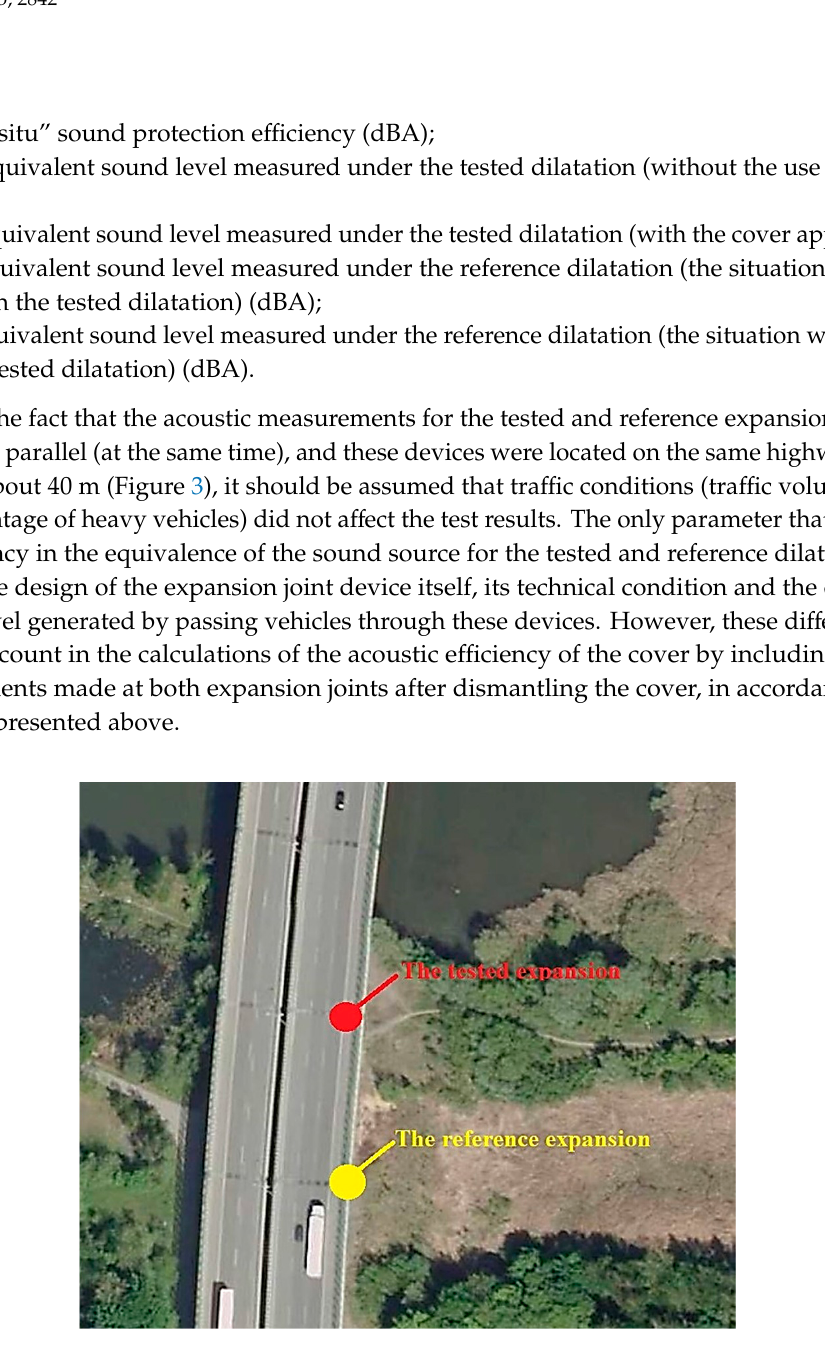
Figure 3. Location of the tested and reference expansion joint.